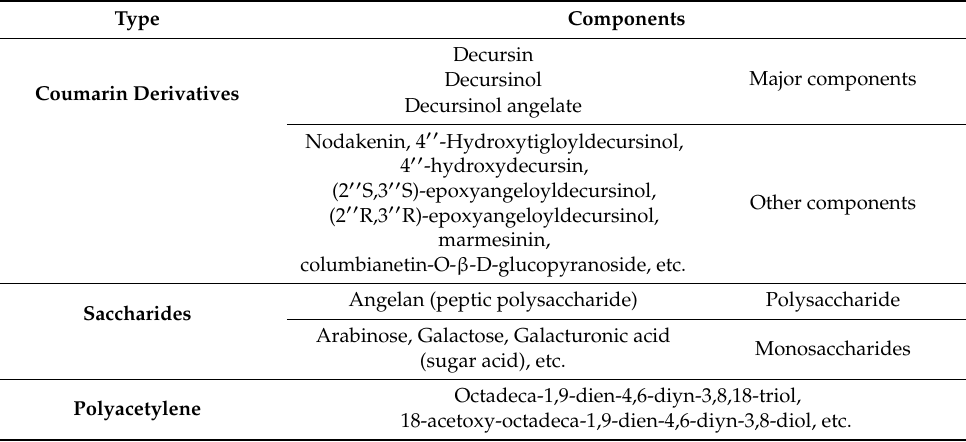
Table 1. Composition of ethanol extract of AGN